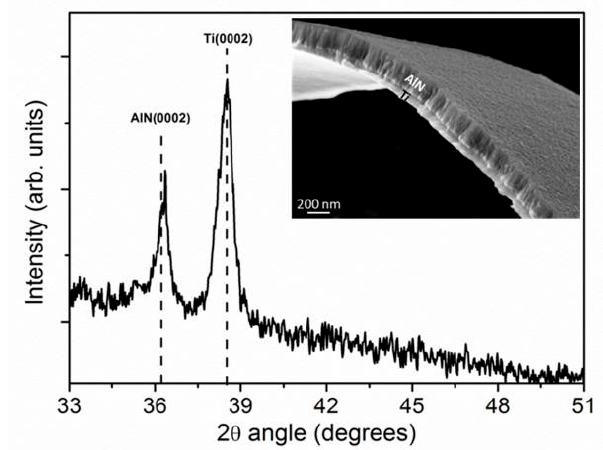
Figure 1. XRD spectrum and SEM image (inset) of Ti/AlN bilayer sputtered on kapton